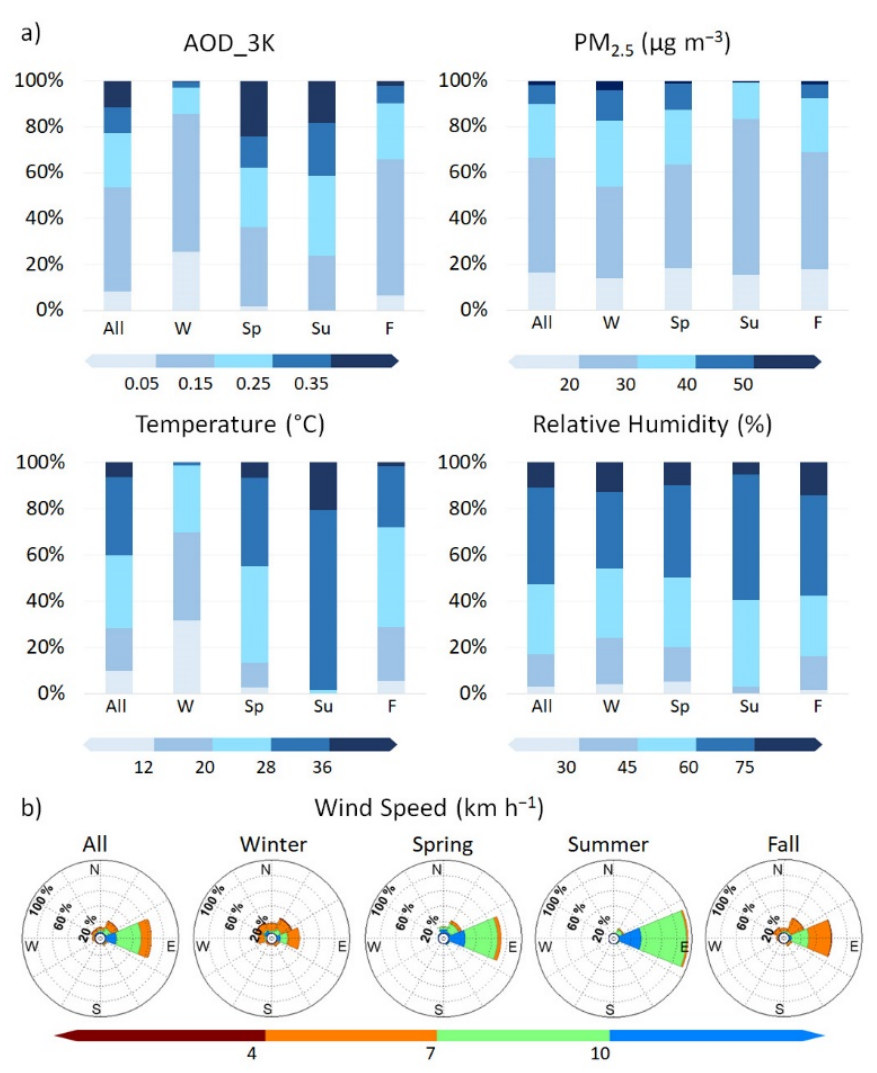
Figure 4. Seasonal data distribution of the best dataset for the period of 2010–2017: ( a ) daily mean AOD_3K and ground-based data (PM 2.5 , temperature, and relative humidity) and ( b ) wind roses for the ground-based wind speed and wind direction. In panel ( a ), W indicates winter, Sp indicates spring, Su indicates summer, and F indicates fall.